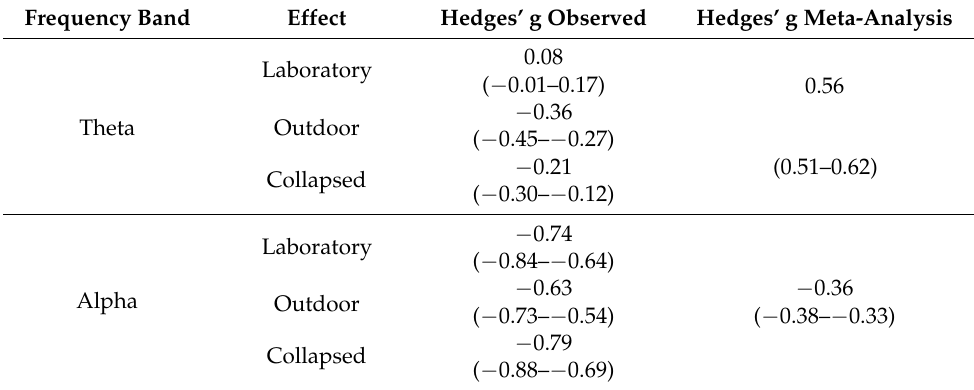
Table 9. Observed versus Meta-Analytic Hedges’ g for EEG Power Main Effect of